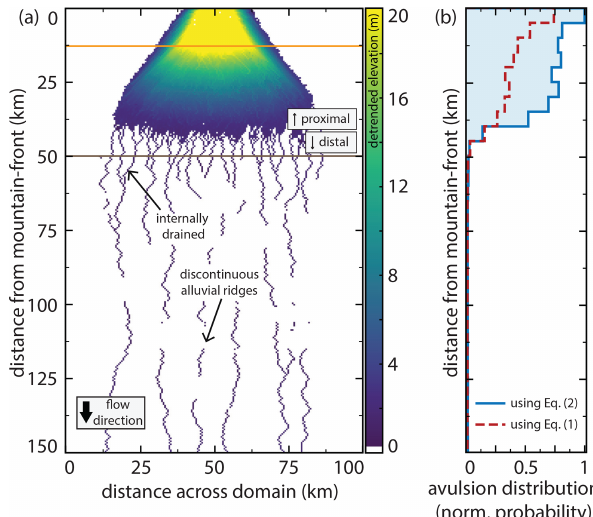
Figure 6. (a) Planform output of detrended high elevations from the base run. The color bar is chosen such that negative or near-zero detrended values appear white. The location of the active channel is not shown. The model produces two distinct domains (proximal and distal) in addition to several marked features which compare well with observed megafans (Fig. 1). Horizontal orange and dark brown lines show the proximal and distal measurement locations, respectively, for Fig. 7a. (b) A histogram (bin width of 6.25km) showing the downstream distribution of avulsion loci. Blue line cor- responds to the model run shown in panel (a) , whereas the dashed red line is an equivalent run that differs by requiring one full chan- nel depth of aggradation to achieve superelevation (Eq. 1) instead of measuring elevation relative to adjacent cells (Eq. 2). The run using Eq. (2) had a mean time between avulsions of 32 years, compared to 57 years for the run using Eq. (1). Vertical axis scale for panel (b) is the same as that for panel (a) .